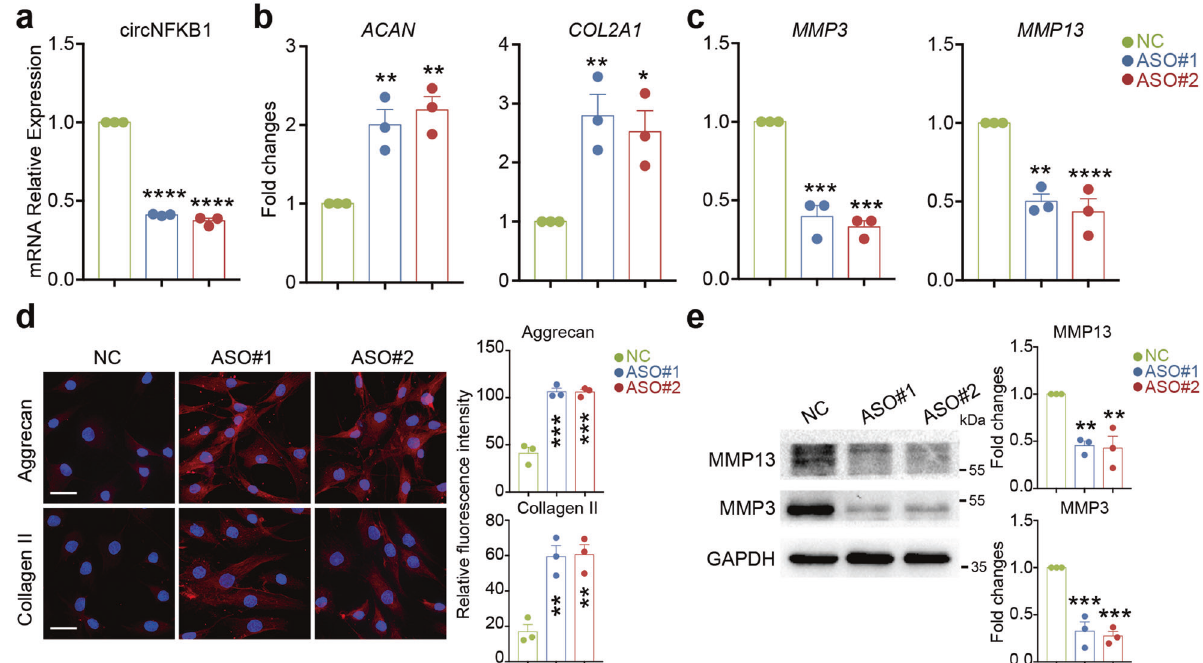
Fig. 3 Knockdown of circNFKB1 suppresses IL-1 β -induced ECM catabolism in human chondrocytes. a qRT-PCR analysis showing circNFKB1 RNA levels in circNFKB1 inhibited HCs. b , c qRT-PCR analysis mRNA levels of ACAN , COL2A1 , MMP3, and MMP13 in circNFKB1 inhibited HCs with IL-1 β stimulation. d Representative immuno fl uorescence images of of Aggrecan and Collagen II protein levels in chondrocytes after circNFKB1 knockdown. Scale bars, 25 μ m. e Western blotting analysis of MMP3 and MMP13 expression in circNFKB1 knockdown group. a – e n =